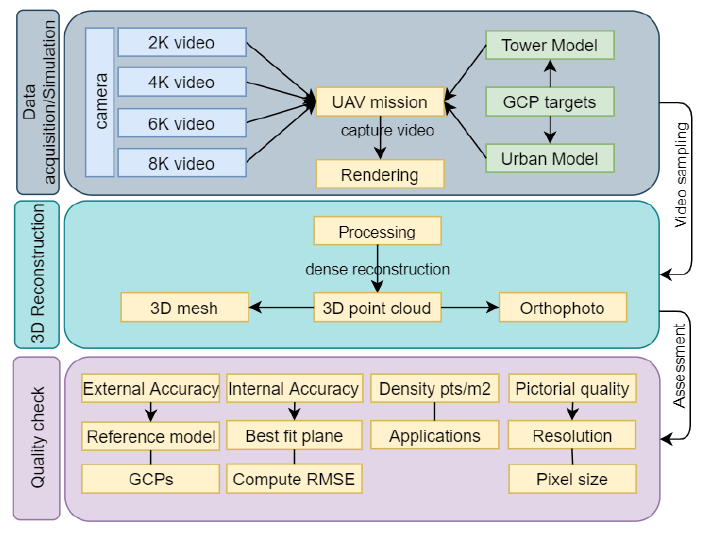
Figure 5. The workflow of the methodology.